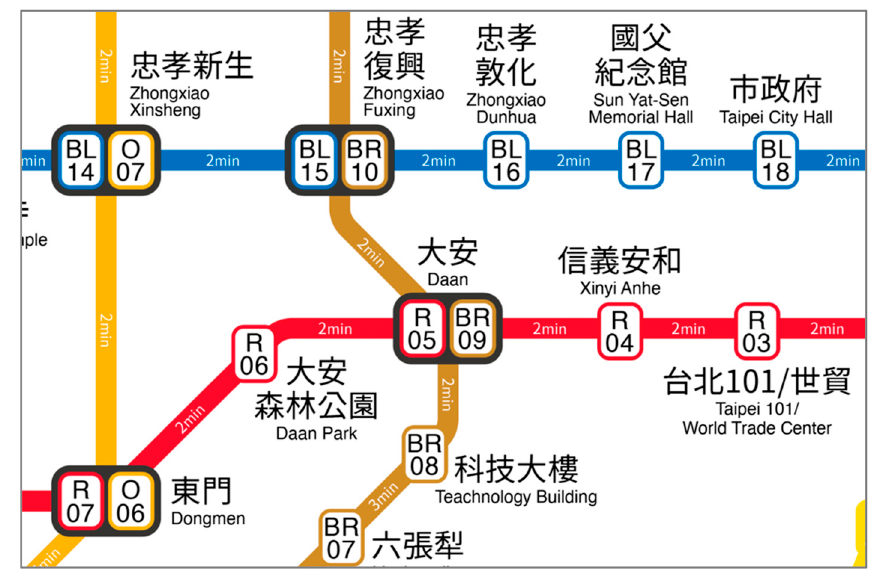
Figure 7. Considering the number of transfers to avoid detours.